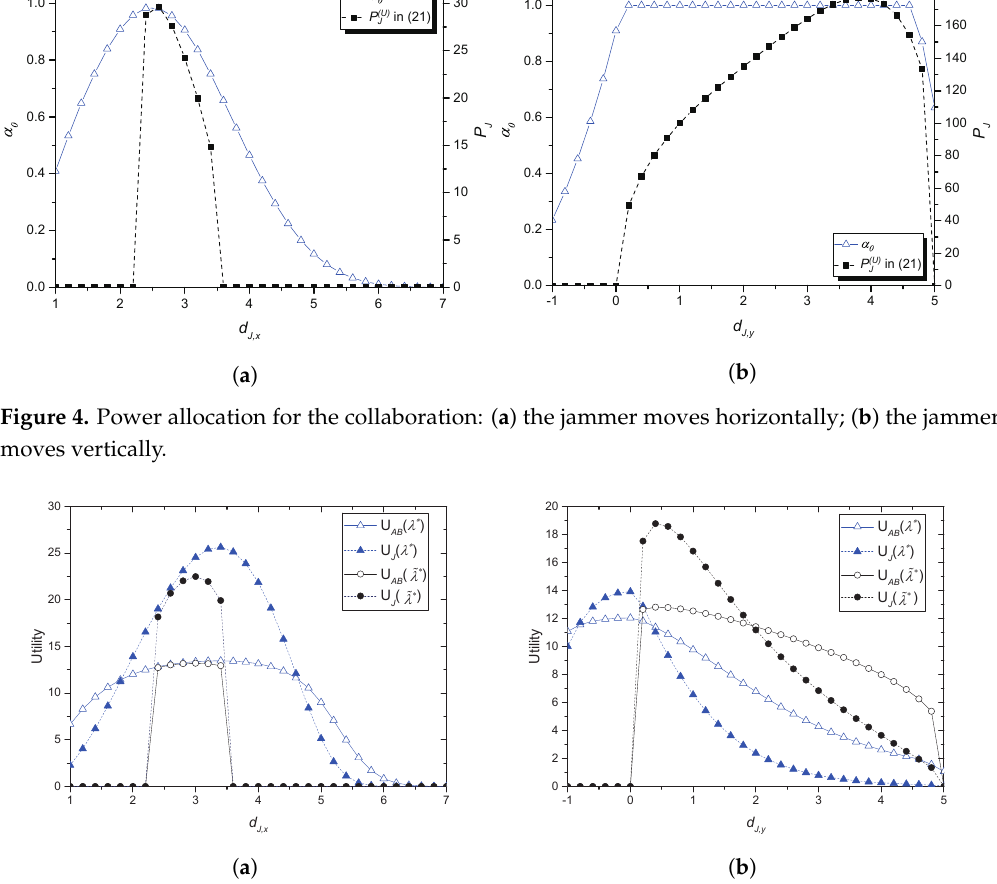
Figure 5. Utilities obtained by the collaboration: ( a ) the jammer moves horizontally; ( b ) the jammer moves